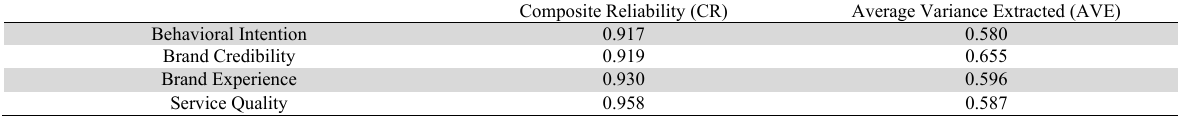
Average Variance Extracted (AVE) and Composite Reliability (CR)